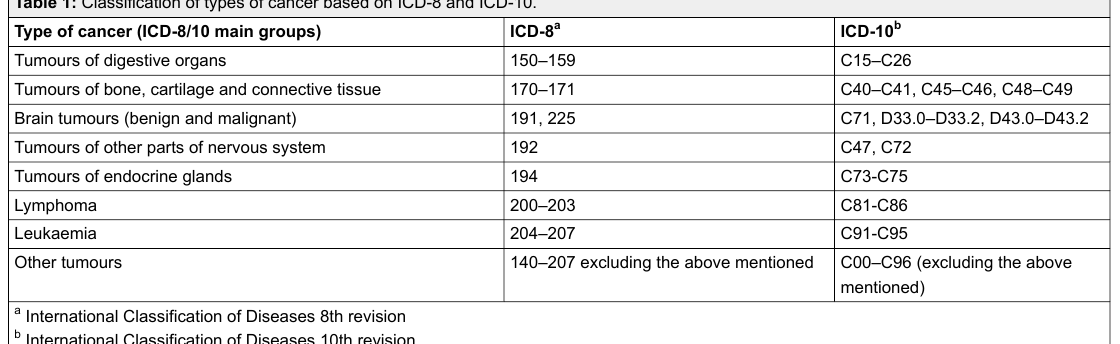
Table 1: Classification of types of cancer based on ICD-8 and ICD-10. Type of cancer (ICD-8/10 main